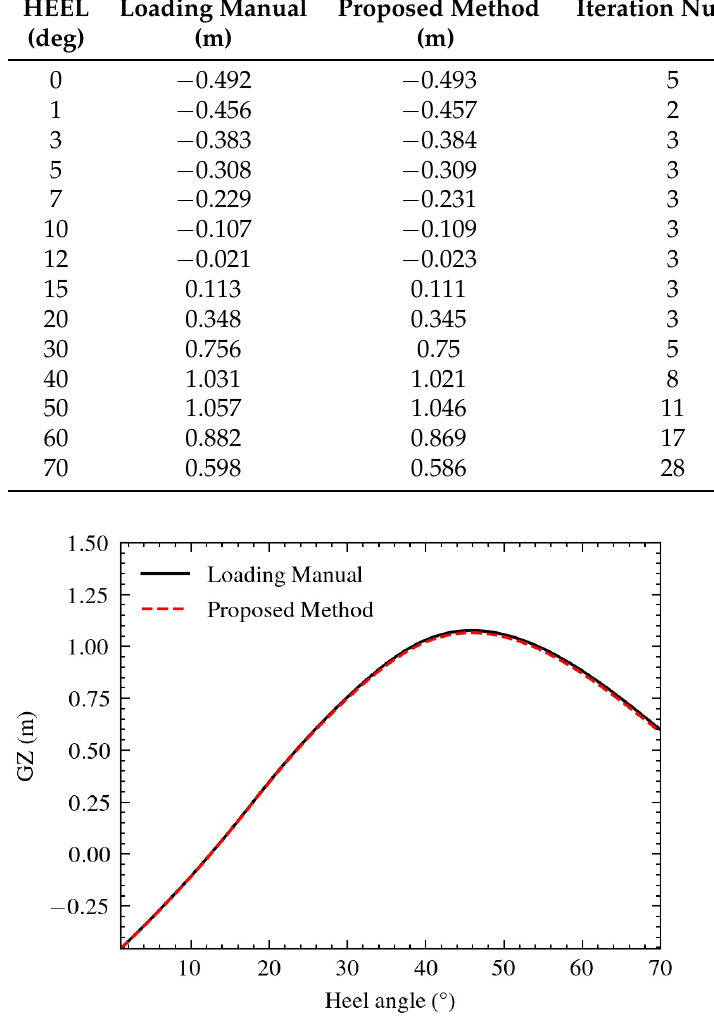
Figure 14. GZ curve of